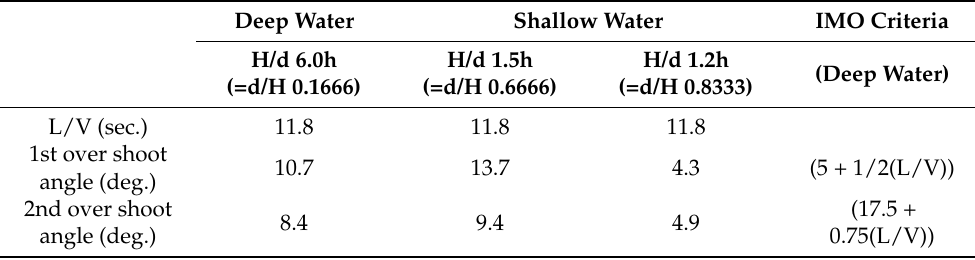
Table 11. Comparison of 10/10 zig-zag simulation results by ship-draft to water-depth